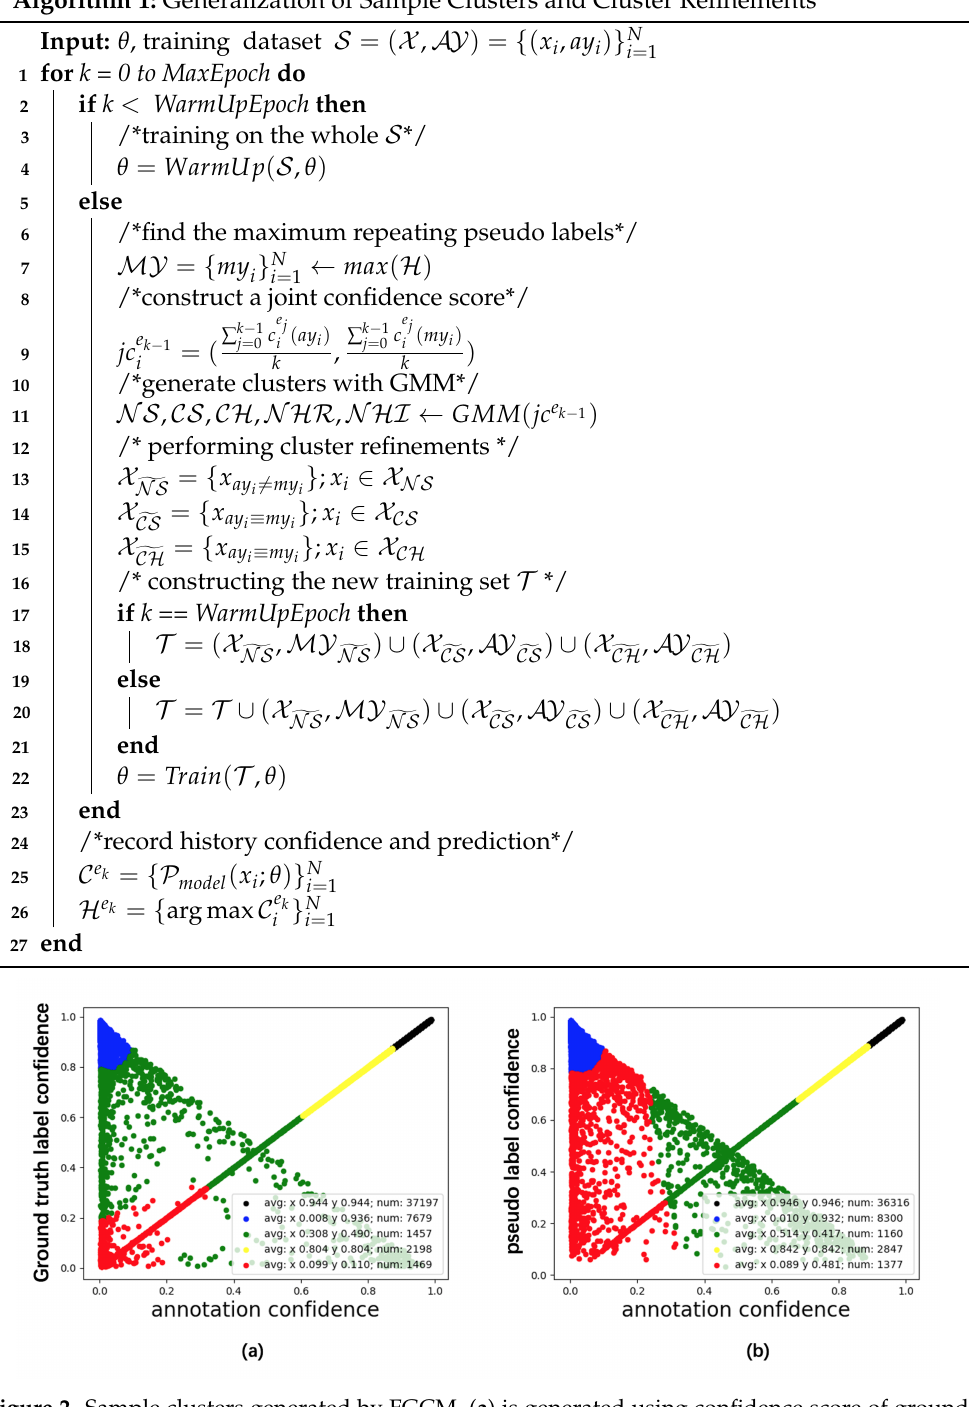
Algorithm 1: Generalization of Sample Clusters and Cluster Refinements